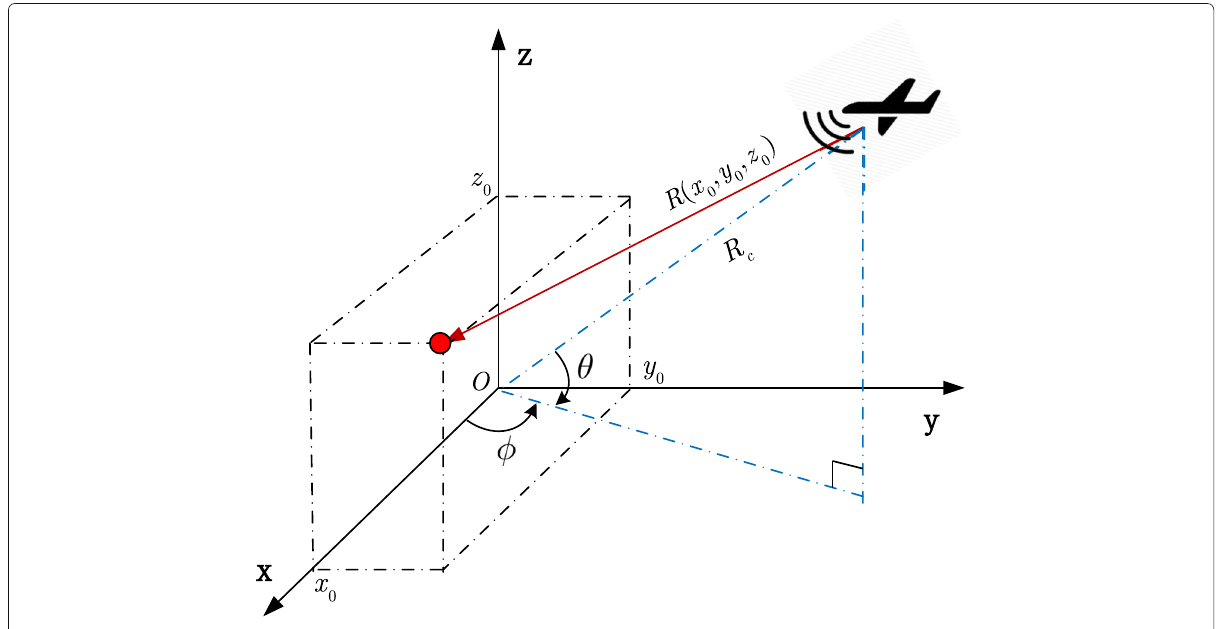
Fig. 1 The geometry of spotlight SAR for point scatterers